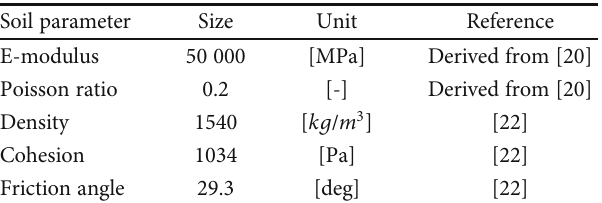
Figure 4: Overview of the FEM model with boundary conditions, dimensions, and global interface to rigid body. Table 2: Soil properties and references used for the fi nite element